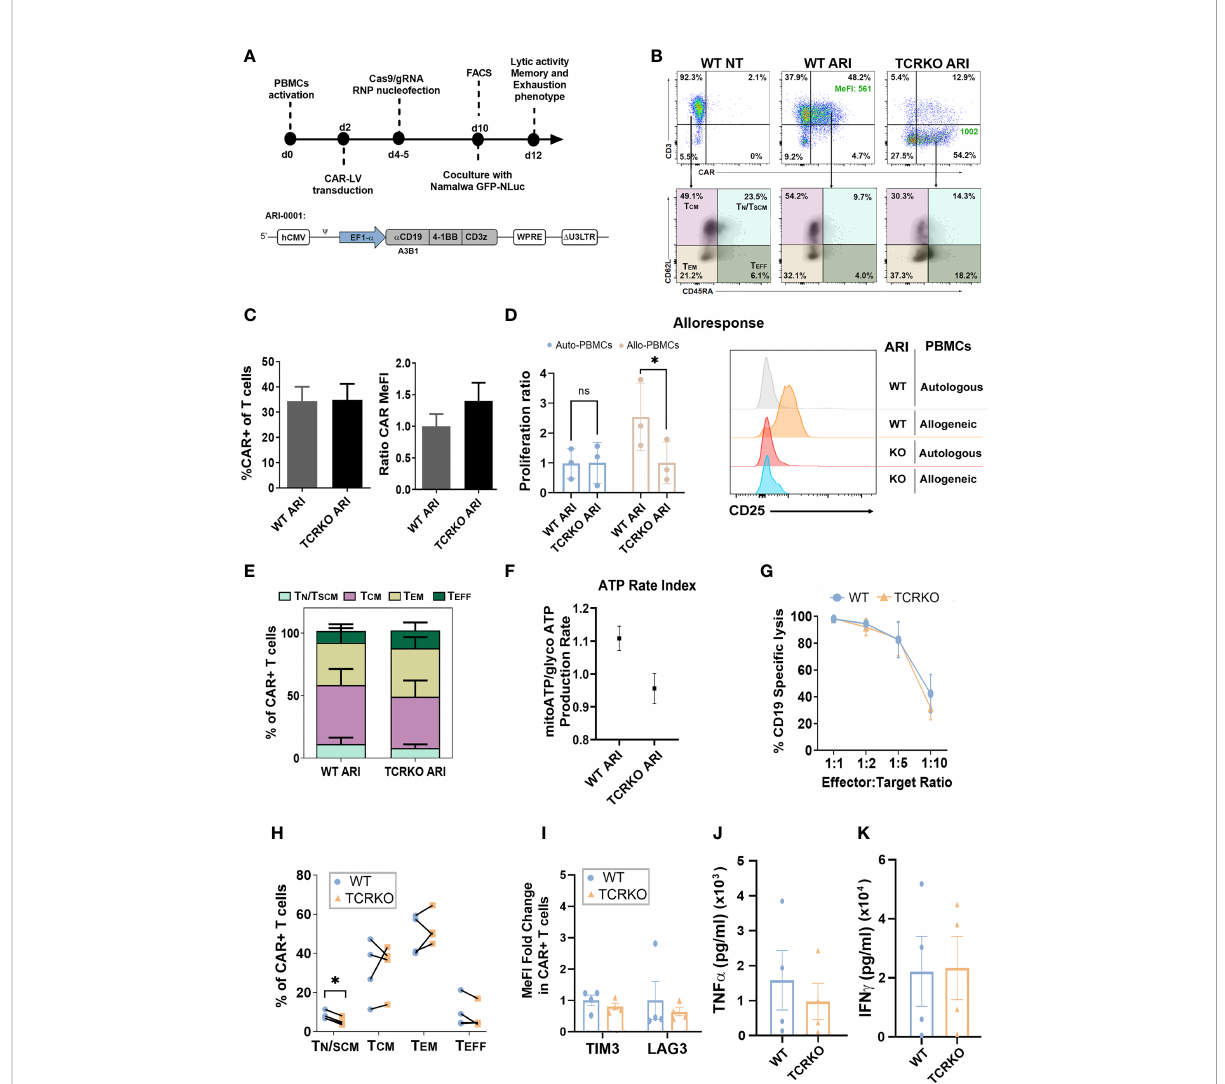
FIGURE 3 Generation of Universal a -CD19 CAR-T cells. (A) Top: Work fl ow of the experiments. Bottom: schematic representation of the ARI-0001-LV expressing a -CD19 CAR. (B) Top: Representative dot-plots showing CAR expression levels in control (WT NT, left), ARI-0001 (WT ARI, middle) and genome edited ARI-0001 (TCRKO ARI, right) T cells. Percentages (%) of CAR+ cells and expression levels (Median of Fluorescent Intensity – MeFI) are shown. Bottom: Dot-plots showing CD62L and CD45RA expression of control (left), ARI-0001 CAR (middle) and TCRKO ARI-0001 CAR (right) T cells. Percentages of T N /T SCM , T CM , T EM and T EFF are indicated. (C) Graphs showing the %CAR+ cells in TCRKO and WT CAR-T cells (left) and the relative CAR expression level (MeFI) related to WT ARI-0001 (right) (7 independent donors, n=11). (D) Alloresponse analysis. WT ARI-0001 and TCRKO ARI-0001 CAR T cells were labelled with Cell Trace Violet (CTV) and co-cultivated with allogeneic (allo) or autologous (auto) PBMCs. Graphs showing the proliferation ratio (left) and CD25 expression (right) of each CAR-T after 6 days of co-culture determined by FACS (3 independent donors, n=3). (E) Percentage of T N /T SCM , T CM , T EM and T EFF in non-stimulated TCRKO and WT ARI-0001 cells (4 independent donors, n=4). (F) Graph showing ATP rate index calculated by the ratio of mitochondrial ATP divided by glycolytic ATP. Donors = 2. Three replicates each. (G) Graph comparing speci fi c lysis of CD19+ cells by WT and TCRKO CAR T cells at different effector:target (E:T) ratio after 48h of co-culture (4 independent donors, n=4). (H) Percentage of T N /T SCM , T CM , T EM and T EFF in TCRKO and WT ARI-0001 cells after 48h of co-culture with Namalwa cells at E:T ratio 1:2 (4 independent donors, n=4). (I) Fold change of TIM3 and LAG-3 expression levels of TCRKO ARI-0001 related to the expression in WT ARI-0001 cells after 48h of co-culture with Namalwa cells at ratio 1:2 (4 independent donors, n=4). (J) Secretion of human TNF- a and (K) IFN- g from effector cells in response to target cells after 24 hours of co-culture (4 independent donors, n=4). Statistics are based on paired, two-tailed Student´s t-test (D, H) , *p<0.05. Graphs show mean ±